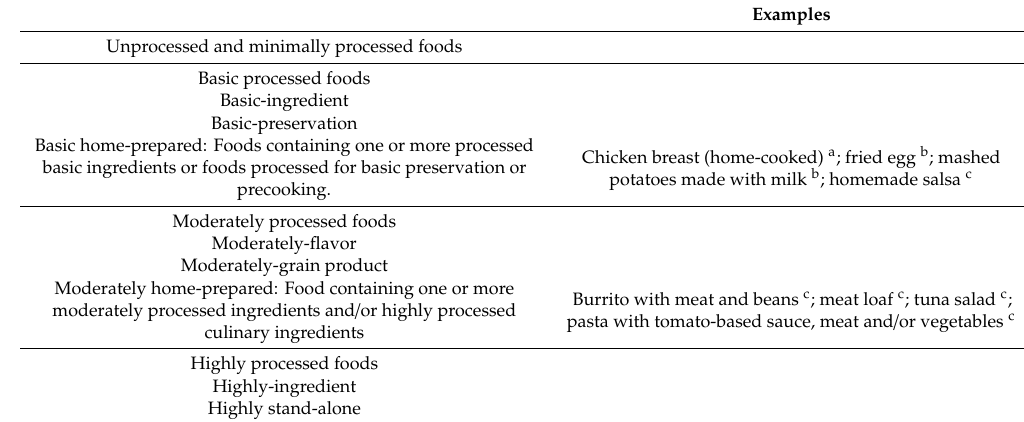
Table 2. The ‘home processing’ food processing classification system adapted from the University of North Carolina at Chapel Hill 13 framework to di ff erentiate between home-prepared and industrially produced mixed dishes (adapted categories and definition shown in